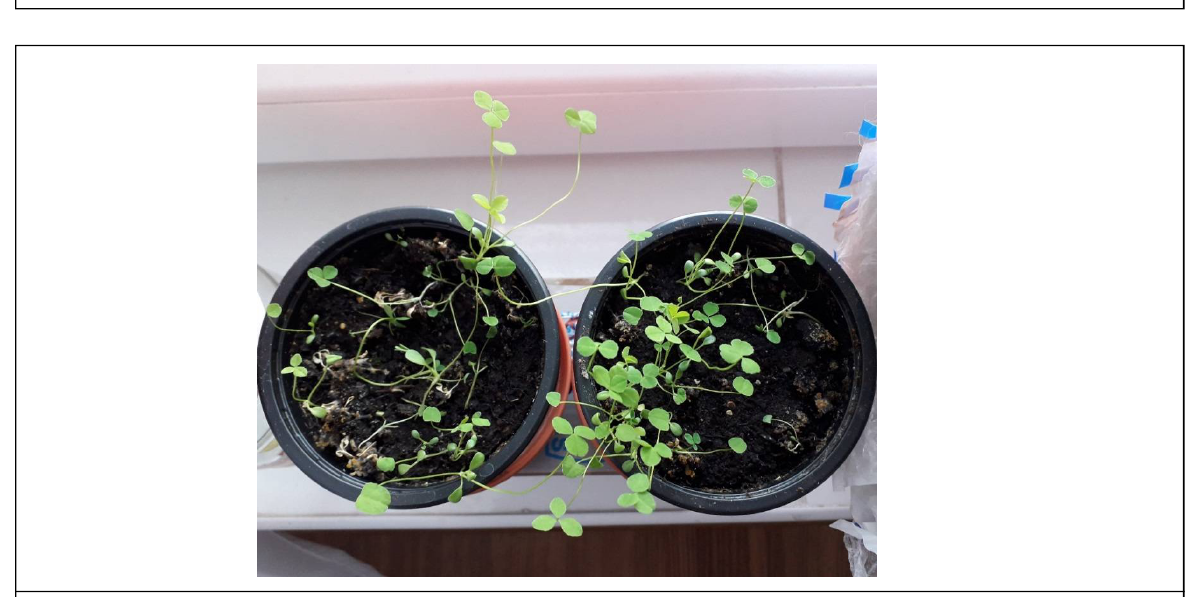
Figure 5: On the left is ordinary water, on the right is magnetized water (May 9,